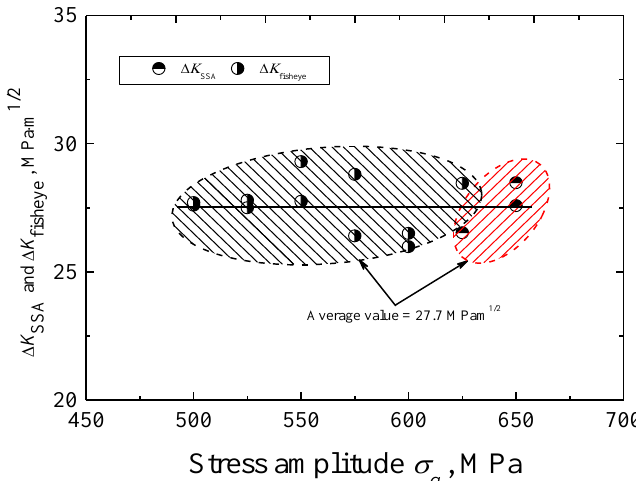
Figure 11. Relationships between stress intensity factor of SSA ( Δ K SSA ), stress intensity factor of fisheye (Δ K fisheye ) and σ a .